Question: From the figure, is the trend upward or downward?
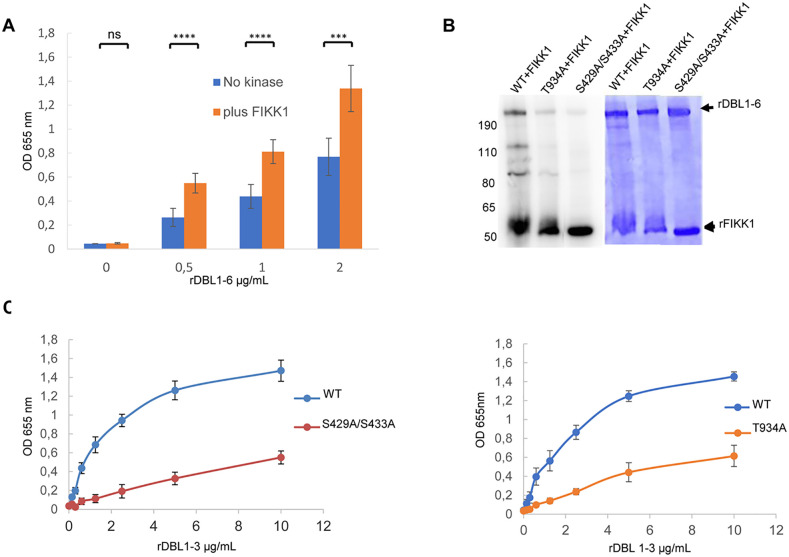
Answer: increasing